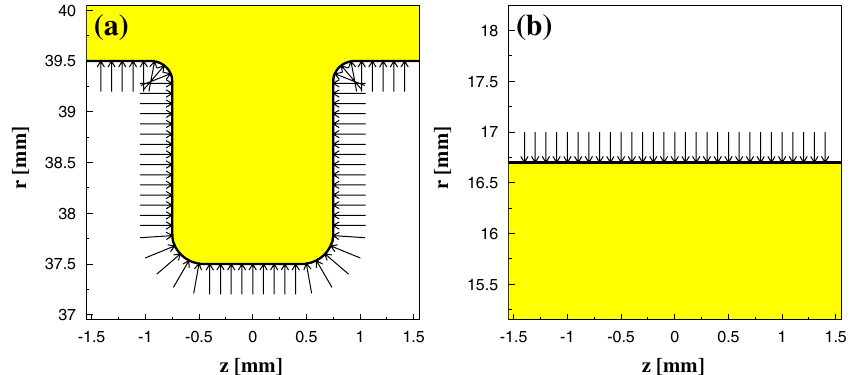
FIG. 4. Initial positions of primary electrons for the (a) outer and (b) inner conductors of the coaxial line are indicated by arrows for a pitch of 3.0 mm and a depth of 2.0 mm. In this example, N ð z Þ p ¼ 94 and ~ N ð z Þ p ¼ 58